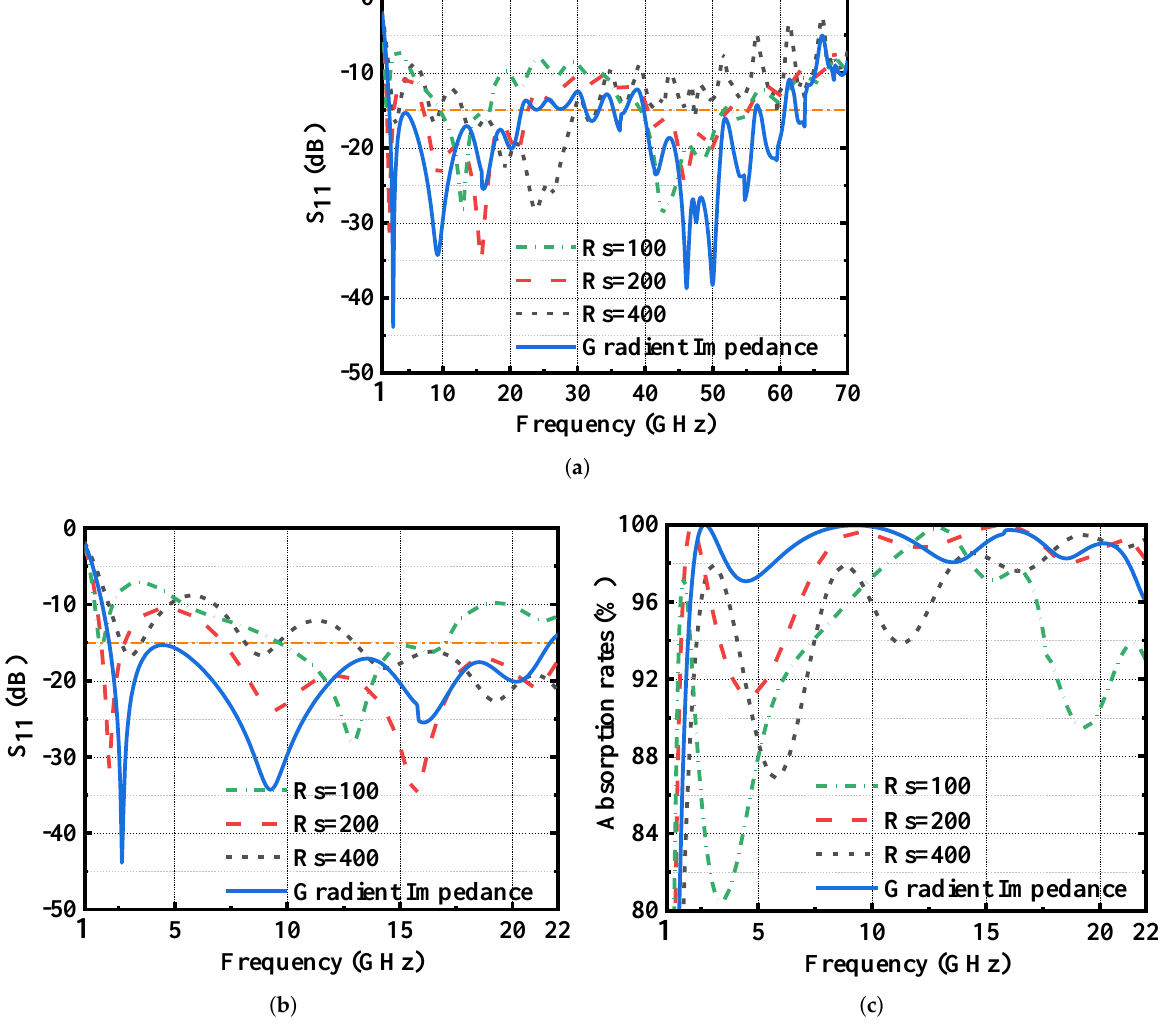
Figure 4. Comparison between absorbers with gradient and uniform films. ( a ) Simulated S 11 among 1 − 70 GHz. ( b ) Simulated S 11 among 1 − 22 GHz. ( c ) Simulated absorptivity among 1 − 22